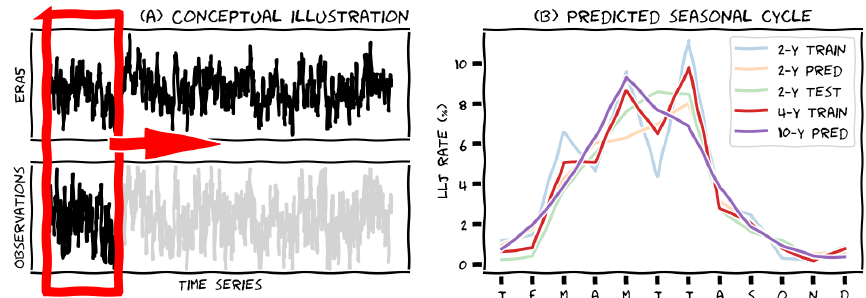
Figure 10. (a) Illustration of the MCP, MOS, or machine learning (ML) procedure in which a (logistic) model is trained with observation data and then used to predict long-term characteristics. (b) Illustration of the MMIJ seasonal cycle of low-level jets based on 2 years of observed data (train), 2 years of predicted (pred) and observed data (test), 4 years of observed data (train), and 10 years of predicted data